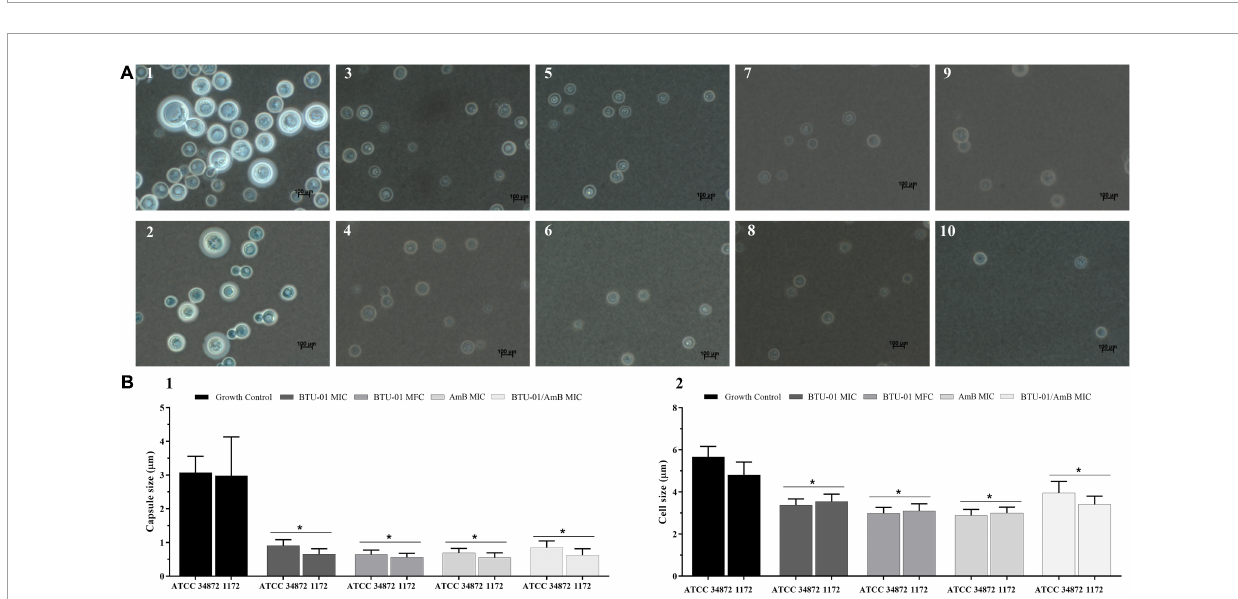
FIGURE4 Effect of N -(butylcarbamothioyl) benzamide (BTU-01) and amphotericin B (AmB) alone or combined on capsule and cell sizes of Cryptococcus neoformans. (A) C. neoformans ATCC 34872 (1, 3, 5, 7, and 9) and C. neoformans 1172 (2, 4, 6, 8, and 10) were negatively stained with Chinese ink and visualized by light microscopy. (1 and 2) untreated cells; (3 and 4) BTU-01 MIC; (5 and 6) BTU-01 MFC; (7 and 8) AmB MFC; (9 and 10) BTU-01/AmB MIC. (B) The results of capsule (B1) and cell (B2) sizes were expressed in graphs and compared to the untreated controls. A total of 100 cells were measured and the mean ± standard deviation was calculated and analyzed by One Way ANOVA, * p <